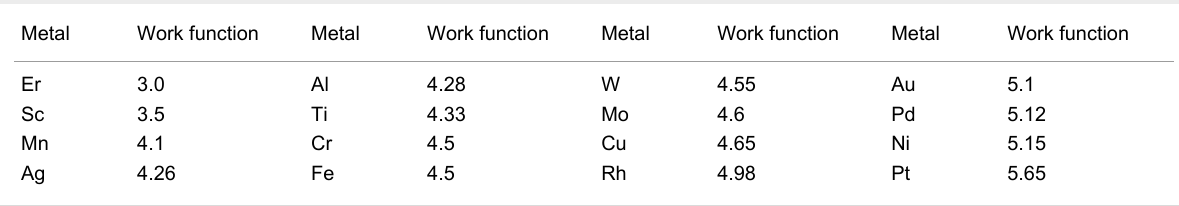
Table 1: Work function of various metals [63] (units: